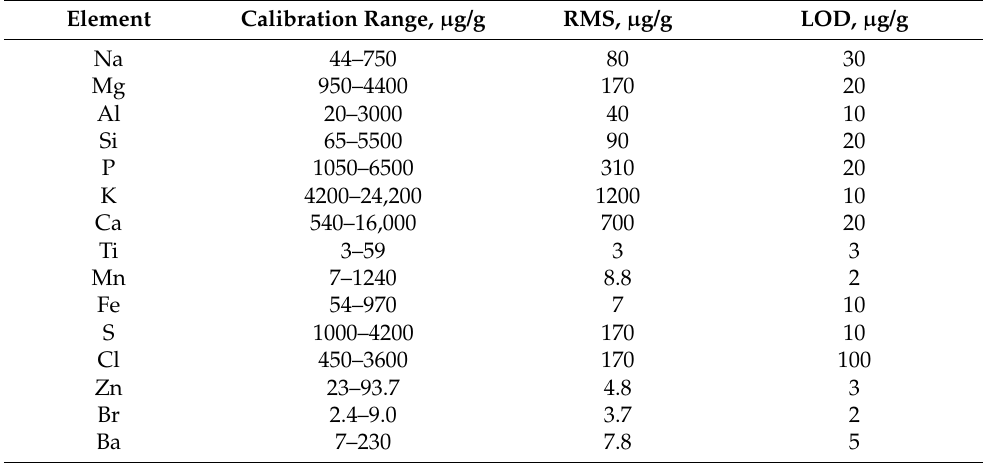
Table 2. Statistical data obtained for WDXRF analysis of major oxides in soil samples.